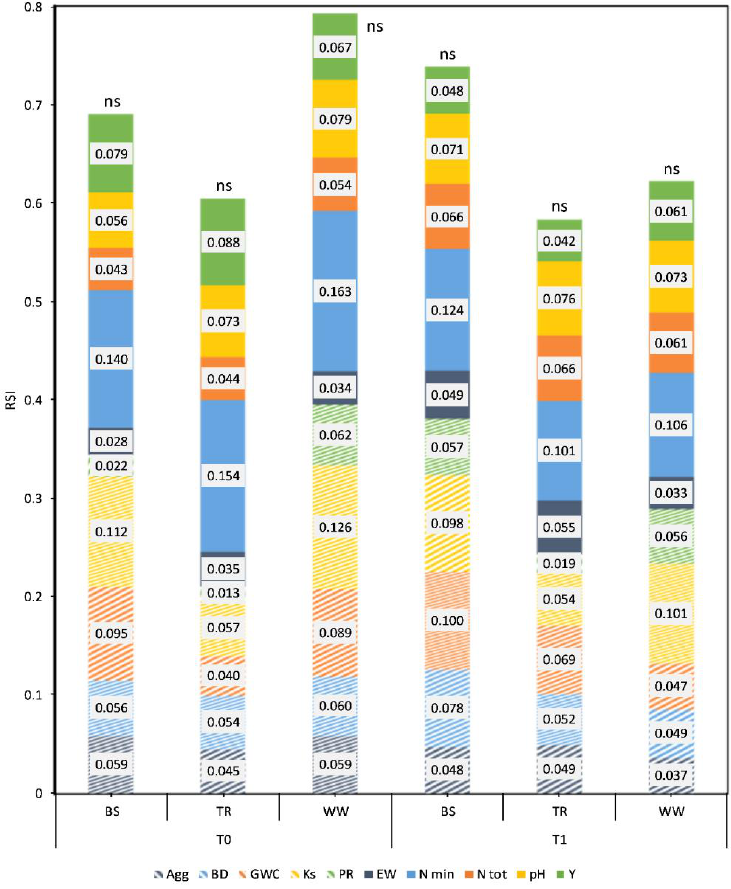
Figure 4. Average RSI values for different soil coverings in different years. BS — bare soil; TR — tillage radish; WW — winter wheat. Agg — aggregate stability; BD — bulk density; GWC — gravimetric water